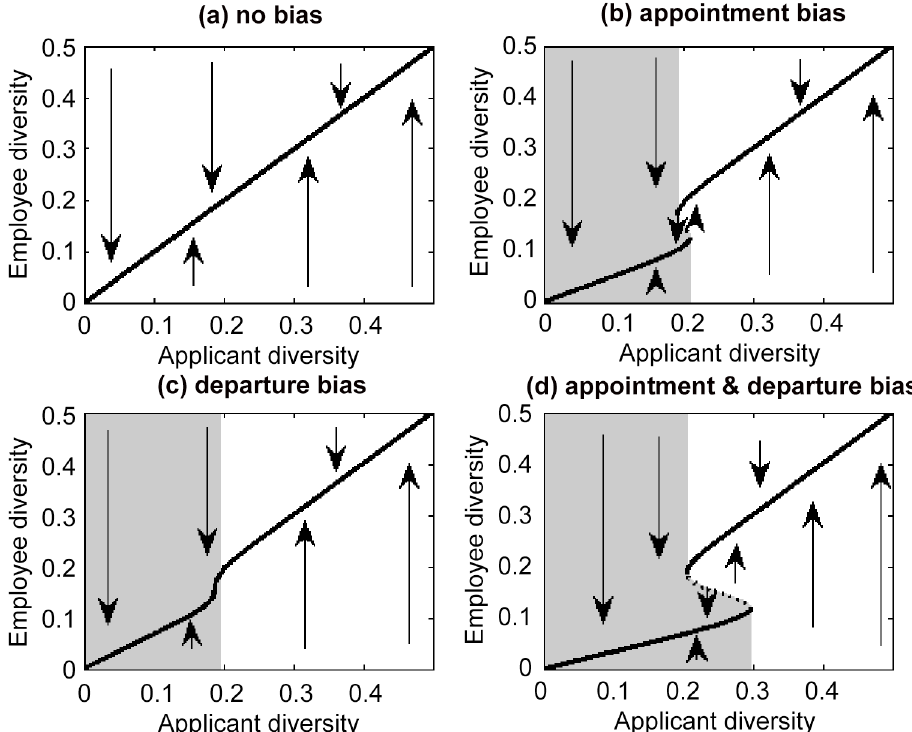
Fig 4. Predicted relationship between applicant diversity and equilibrium employee diversity: solid line and dashed lines represent stable and unstable equilibriums respectively. In the shaded area, the equilibrium employee diversity is less than the applicant diversity: the organization is trapped in a low diversity state due to bias in appointment and/or departure. Arrows indicate trajectory.